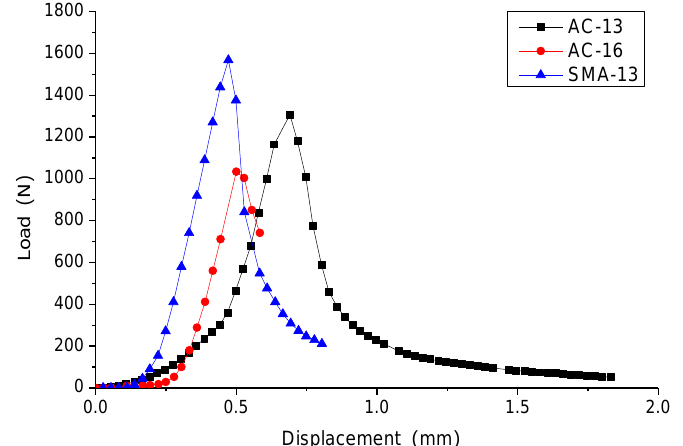
Figure 4. Load-displacement diagram of asphalt mixture beams with a notch depth of 0 mm.